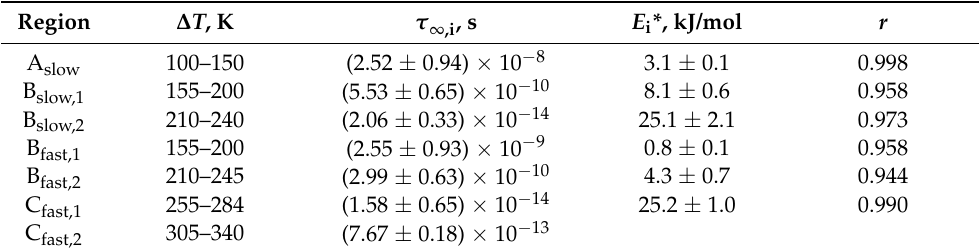
Table 1. The Arrhenius and the Vogel-Fulcher-Tamman-Hesse (VFTH) equations parameters of the spin probe TEMPO dynamics in cis -1,4-PIP10k. B iVFTH = 503.3 ± 49.6; T 0,iVFTH = 216.7 ± 49.5 K, r =